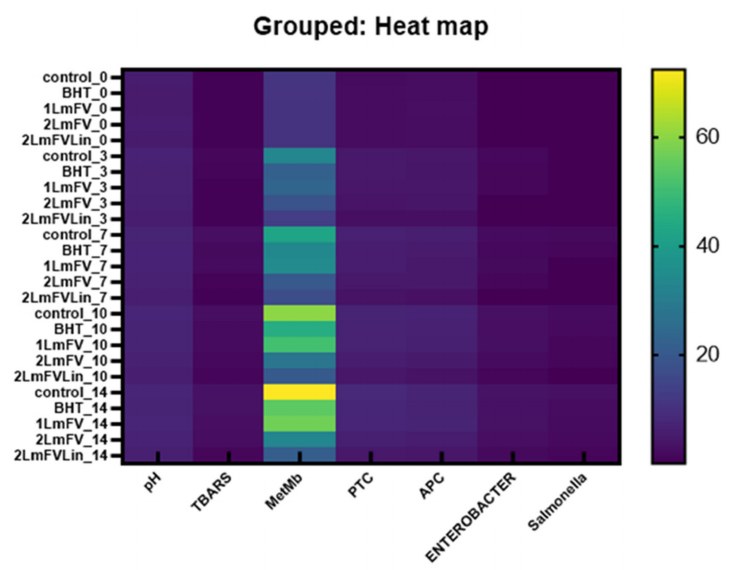
Figure 8. Heat maps of physicochemical properties and microbial growth for different samples during the refrigerated